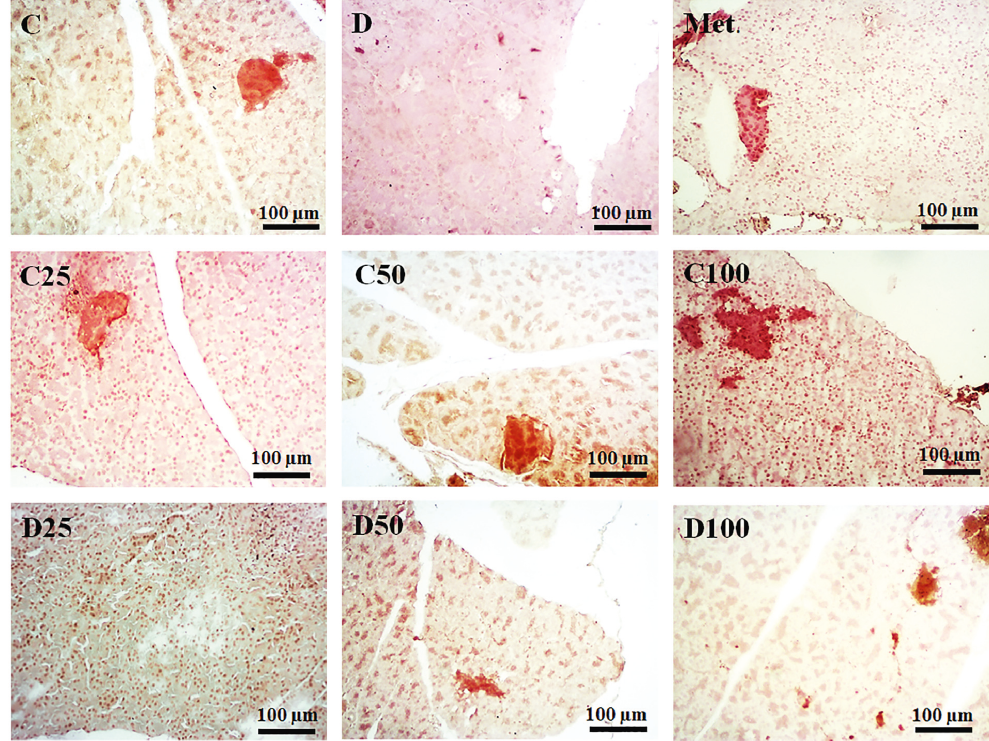
Figure 1: Dithizone staining of pancreatic tissues in all animal groups. The red or DTZ positive regions indicate the B -cells in islets of Langerhans. Administration of metformin or p-cymene obviously increased the B -cell mass in Met, D50, and D100 groups in a dose- dependent manner. C: control rats, D: the sham or diabetic rats, MET: diabetic rats+metformin (55mg/kg), C25: control rats +p-cymene (25mg/kg), C50: control rats+p-cymene (50mg/kg), C100: control rats +p-cymene (100mg/kg), D25: diabetic rats+ p-cymene (25mg/kg), D50: diabetic rats +p-cymene (50mg/kg), and D100: diabetic rats +p-cymene (100mg/kg). Magnification 400x Scale bar 100 μ m.